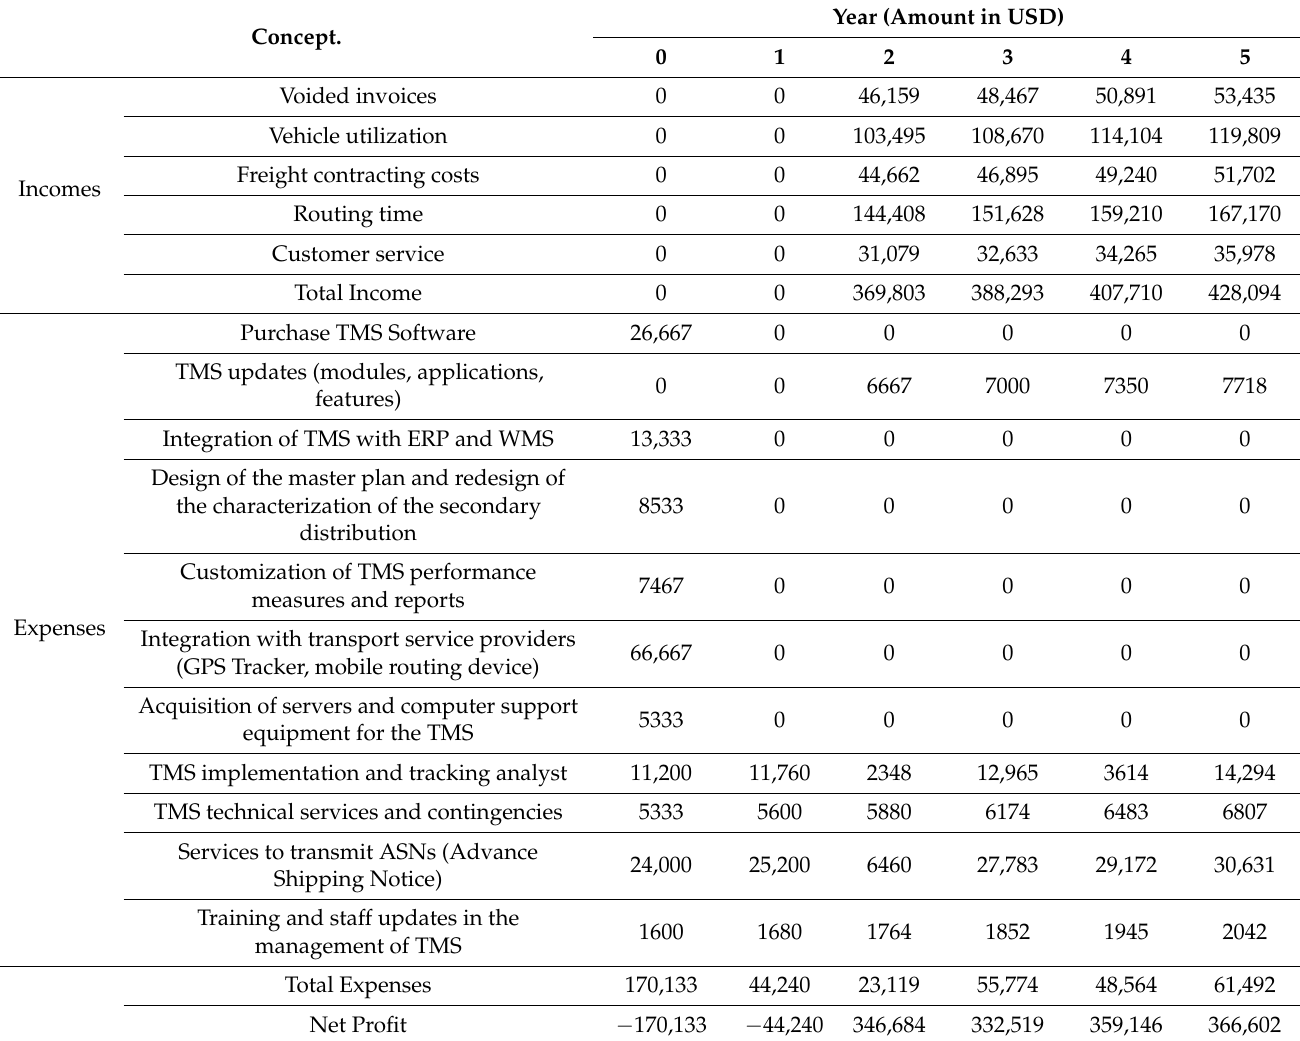
Table 17. Economic analysis of the TMS